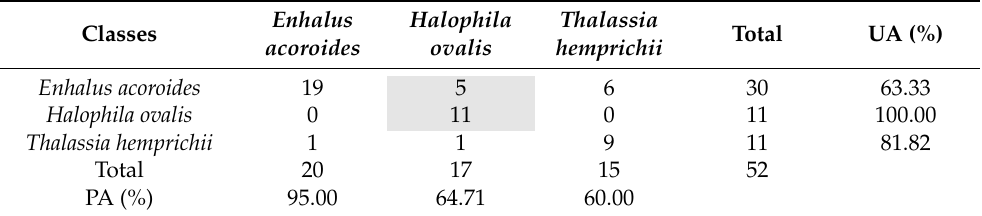
Table 7. The confusion matrix and summary error statistics for seagrass species mapped from the Worldview-2 sensor validated against the field reference data of seagrass species estimated from photo transects. PA is Producer’s accuracy; UA is User’s accuracy. The gray area on the table shows the confusion between Enhalus acoroides and Halophila ovalis